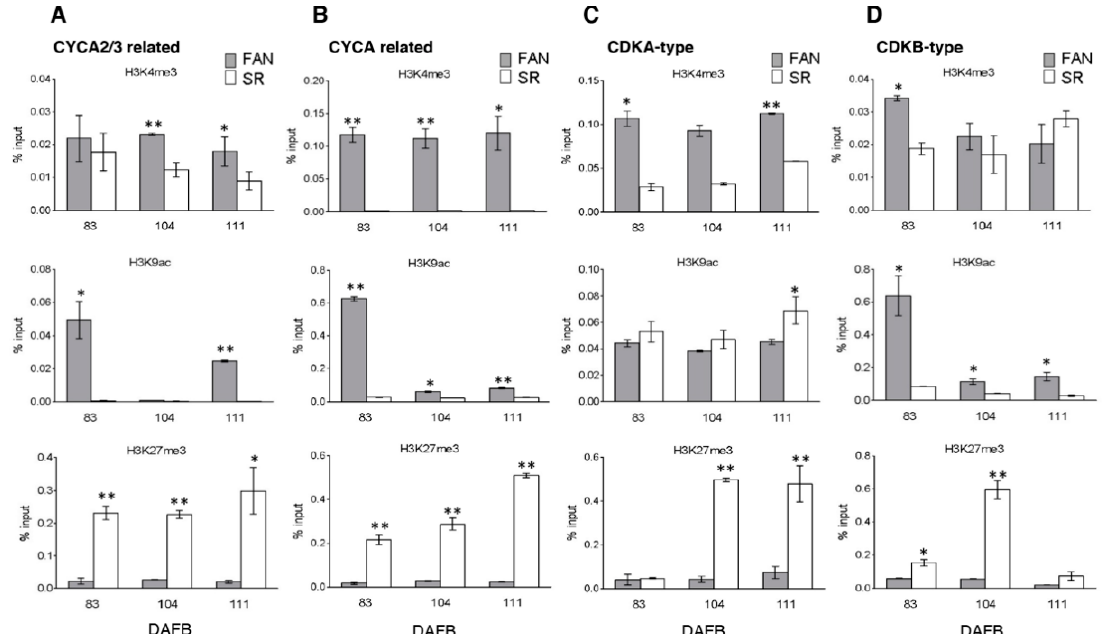
Figure 4. Chromatin mark analysis at target genes controlling cell cycle during the growth period of FANTASIA (FAN) and slow ripening (SR) genotype fruits. Histone modification analysis at CYCA2/3 related (Prupe.3G075200, ( Panel A )), CYCA related (Prupe.1G428100, Panel B ), CDKA-type (Prupe.2G084600, Panel C ), CDKB-type (Prupe.6G299900, Panel D ) loci by real-time PCR quantification of ChIPed DNA immunoprecipitated with α -H3K4me3, α -H3K9ac, and α -H3K27me3 antibodies on chromatin extracted from FAN (grey bars) and SR (white bars) mesocarp tissue at 83, 104, and 111 DAFB. Data are reported as percentage of chromatin input, normalized on background signal (measured by omitting antibody during ChIP procedure) and three PCR repetitions for each ChIP assay. Standard errors are reported. Asterisks indicate statistically significant changes: * = p ≤ 0.05, ** = p ≤ 0.01. DAFB: Days after full